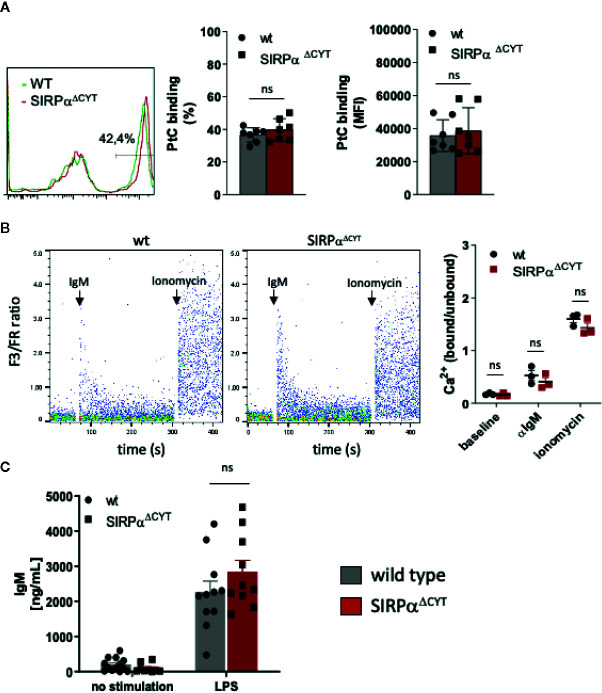
Loss of SIRPα signaling does not have a generalized effect on B1 cell activation. (A) Comparable frequency (FACS plot of representative example, left panel; % positivity, middle panel) and magnitude (MFI, right panel) of phosphatidylcholine (PtC; a typical B1a antigen) antigen binding by wt and SIRPαΔCYT peritoneal cavity B1a cells (n = 7 mice/group). (B) Similar levels of B1a cell surface IgM signaling, as determined by intracellular Ca2+ mobilization, in wt and SIRPαΔCYT peritoneal cavity B1 cells triggered by anti-IgM antibodies; responses with ionomycin are shown as a positive control; left panels: representative examples of Ca2+-responses in wt and SIRPαΔCYT
(B); right panels: average values of B1a cells from n = 3 mice/group. (C) Comparable levels of LPS-stimulated IgM production in B1a cells isolated from SIRPαΔCYT and wt mice (n = 10–11 mice/group); ns, non-significant.